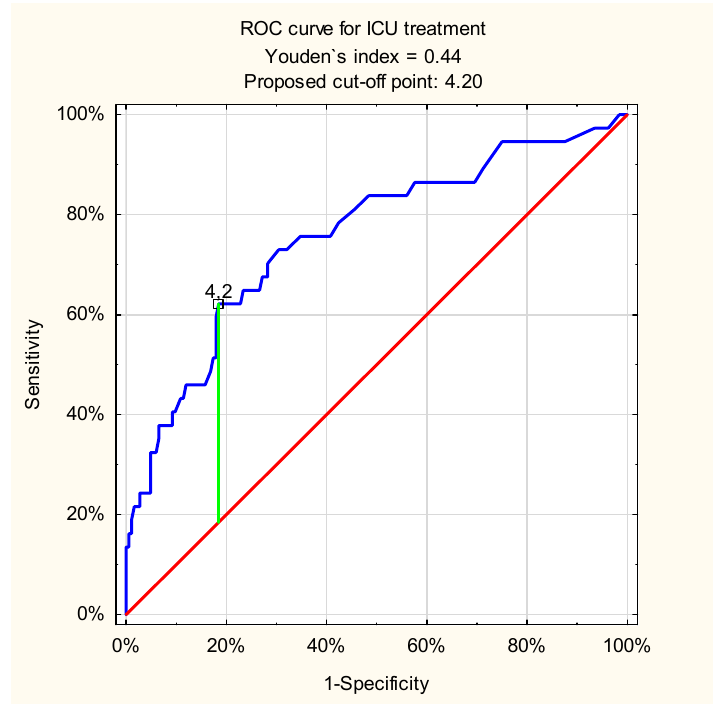
Figure 5. ROC curve for admission venous lactate level and need for ICU treatment in all patients with UGIB (proposed cut-off point = 4.2 mmol/L; sensitivity = 0.62; specificity = 0.82; accuracy = 0.78; AUC = 0.76 (95% CI: 0.66–0.85); p <